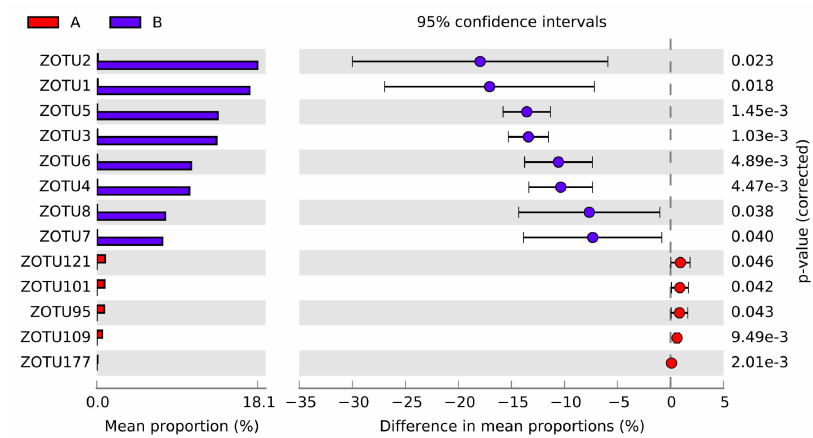
Figure 6. Variation analysis of gill-associated microbial community between G. haimaensis (Group A) and A. marissinica (Group B) at the ZOTUs (zero-radius operational taxonomic units) level. Red bars and dots stand for G. haimaensis , and blue bars and dots stand for A. marissinica